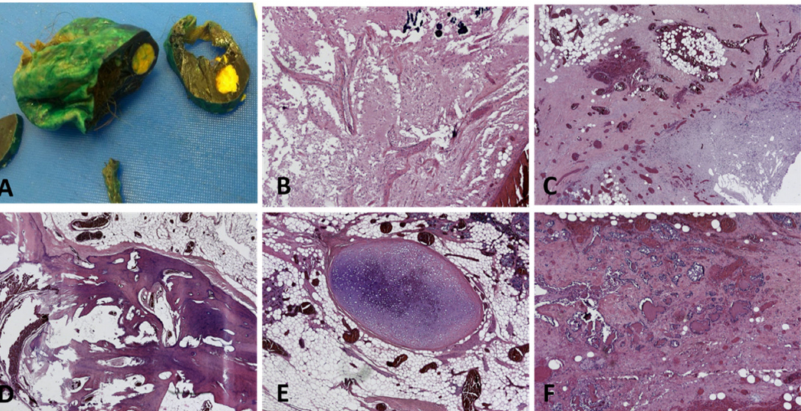
Figure 7. A case of a mature teratoma with torsion artefact in a 36-year-old patient: ( A ) macroscopic aspect of the right adnexa tumor; ( B ) glial type tissue (HE, × 50 magnification); ( C ) ischemic stroma with mature adipose tissue, fibroblastic areas, and thrombosed vessels (HE, × 25 magnification); ( D ) lamellar bone with scarce bone marrow, mature adipose tissue, and congestive vessels (HE, × 25 magnification); ( E ) mature cartilage and adipose tissue with congestive and thrombosed vessels (HE, × 25 magnification); ( F ) ischemic stroma with mature adipose tissue, thyroid follicles, and respiratory type glands (HE, × 50 magnification). (Courtesy of Dr. M.